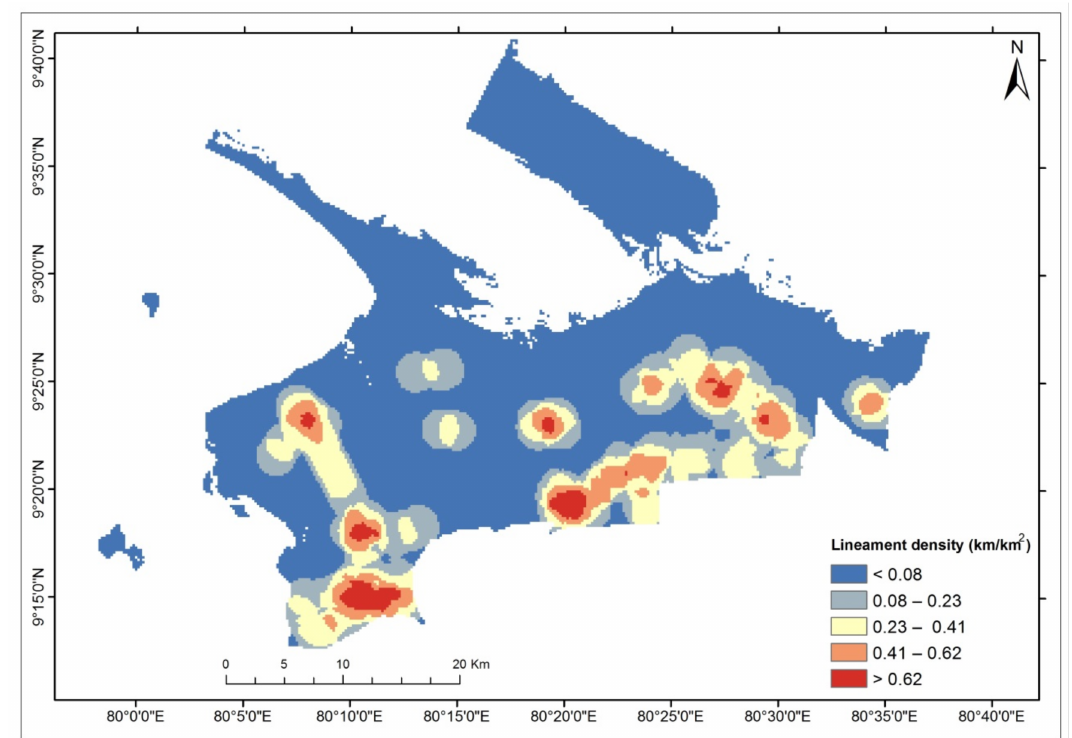
Figure 9. Lineament density map of Kilinochchi District.